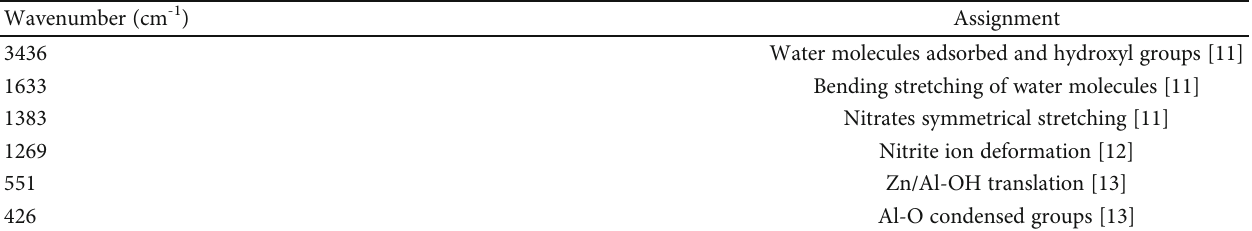
Table 1: Characteristic bands of FTIR spectrum obtained for NO